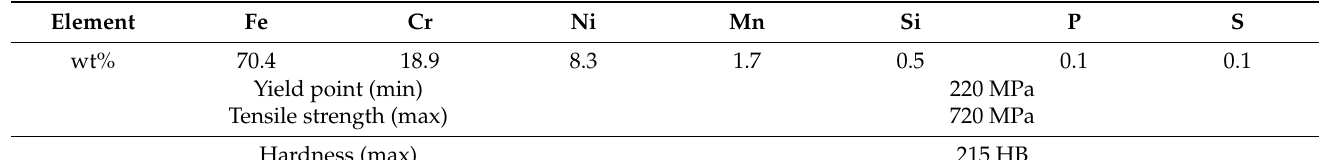
Table 1. Chemical composition and selected properties of X6CrNiTi18 stainless steel.